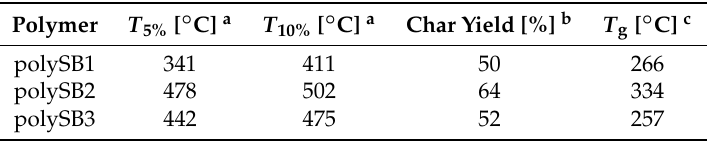
Table 1. Thermal analysis of